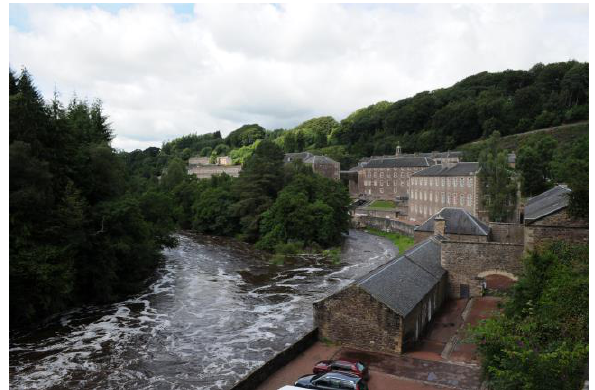
Figure 1. New Lanark village © CDDV